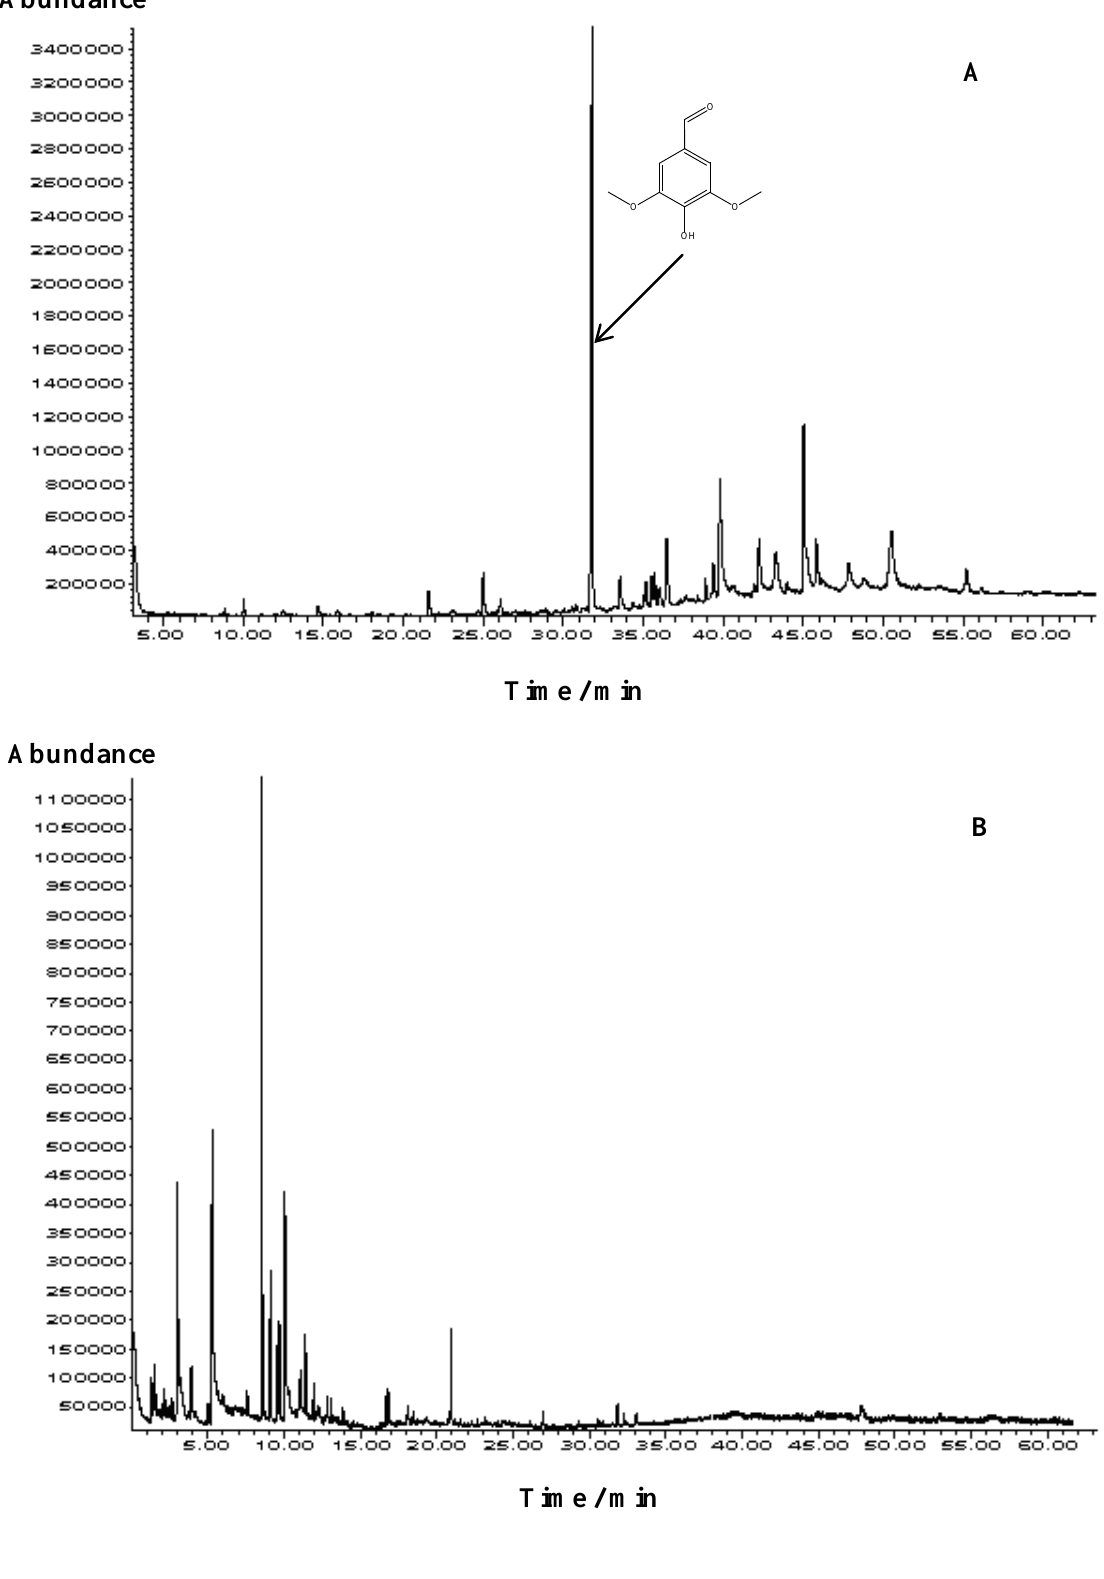
Figure 1. Representative TIC chromatograms of Acer spp. honey dichloromethane extract obtained by USE (A) and headspace obtained by HS-SPME